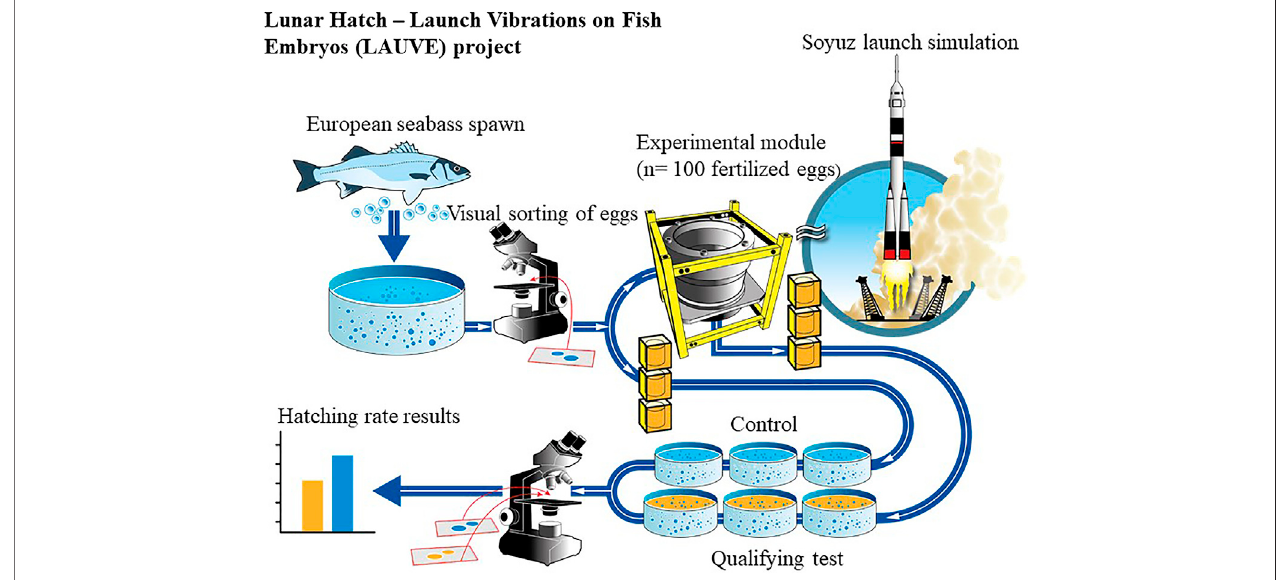
FIGURE 4 | Protocol for the acoustic and mechanical vibrations qualifying test on European seabass embryos (from Przybyla et al., 2020).